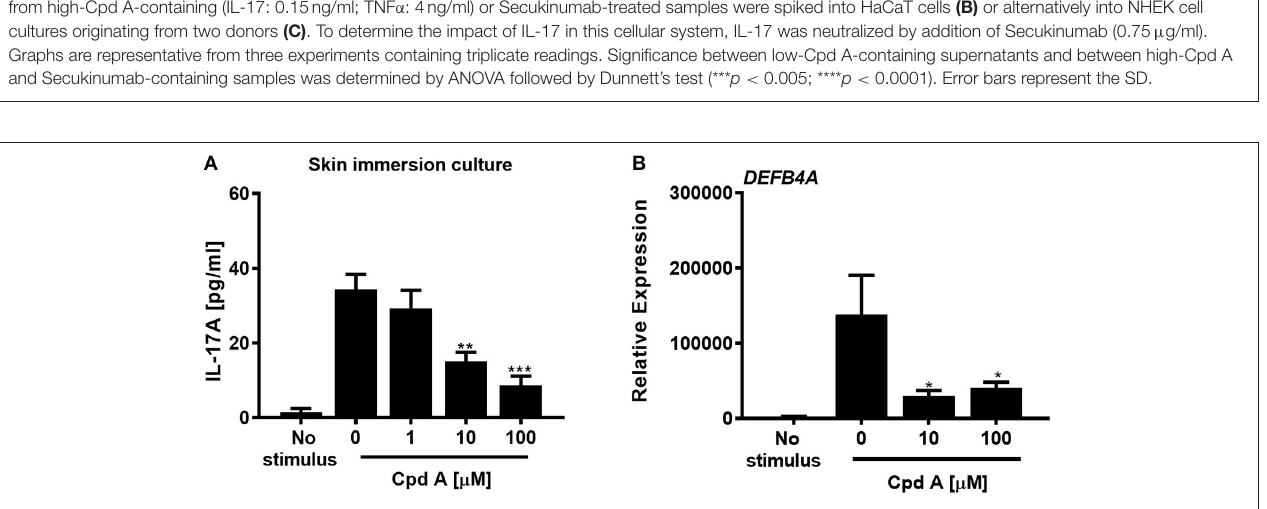
FIGURE 6 | Cpd A inhibits IL-17A production by skin resident immunocompetent cells and impairs DEFB4A expression. (A) Full-thickness skin biopsies (8mm diameter) were incubated with a Th17 cell skewing cytokine cocktail in the presence of various concentrations of Cpd A for 72h followed by quantification of IL-17A production in the supernatants and qRT-PCR analysis of DEFB4A transcript expression in homogenized skin samples (B) . Graphs are representative from two independent experiments and each bar represents mean ± SEM from six replicates. Significant inhibition between no Cpd A treated vs. Cpd A treated samples was determined by ANOVA followed by Dunnett’s test (* p < 0.05; ** p < 0.01; *** p < 0.005). Error bars show the